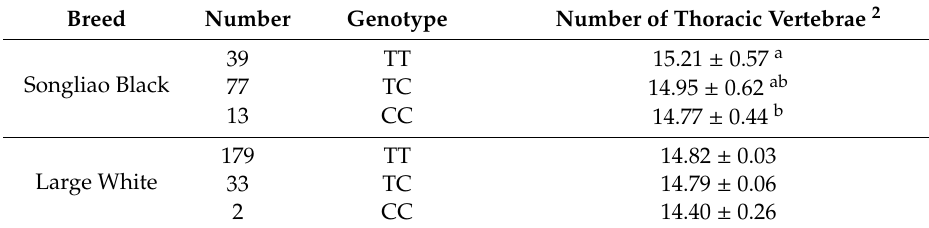
Table 5. The association of S14_87859370 with the NTV in Songliao Black and Large White pigs 1 .